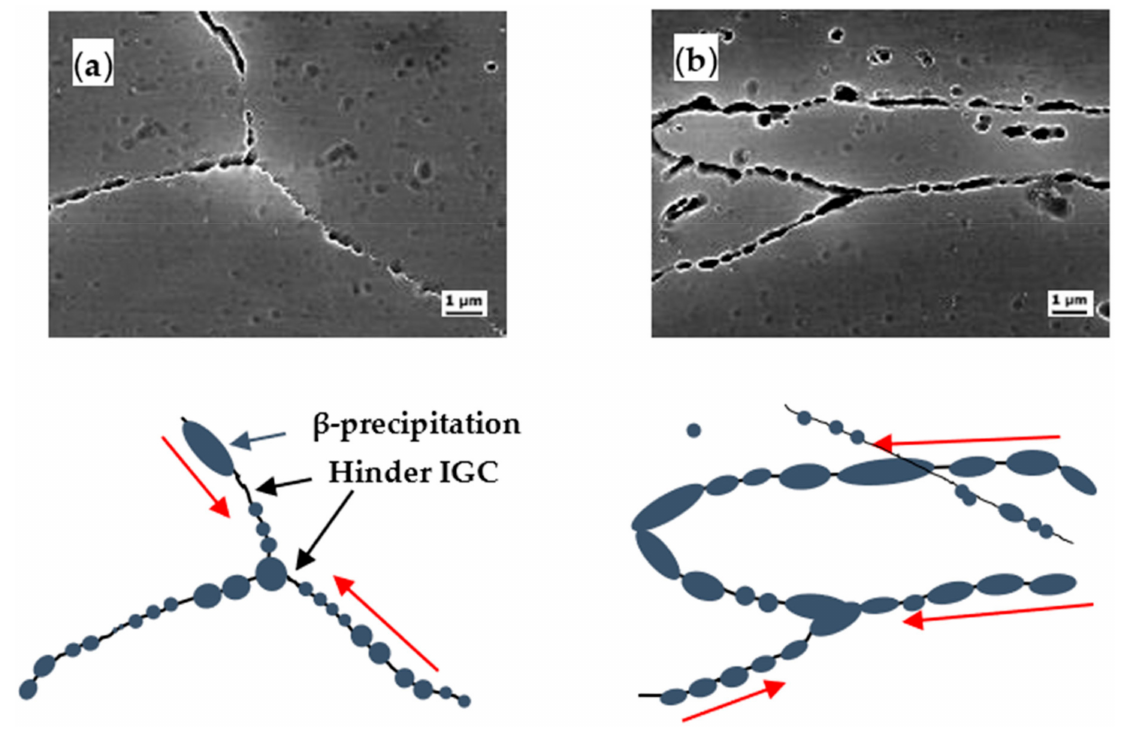
Figure 10. Close inspection of β precipitation covered grain boundary: ( a ) CR20 alloy, Sensi. 48 h, ( b ) CR50 alloy, Sensi. 48 h.